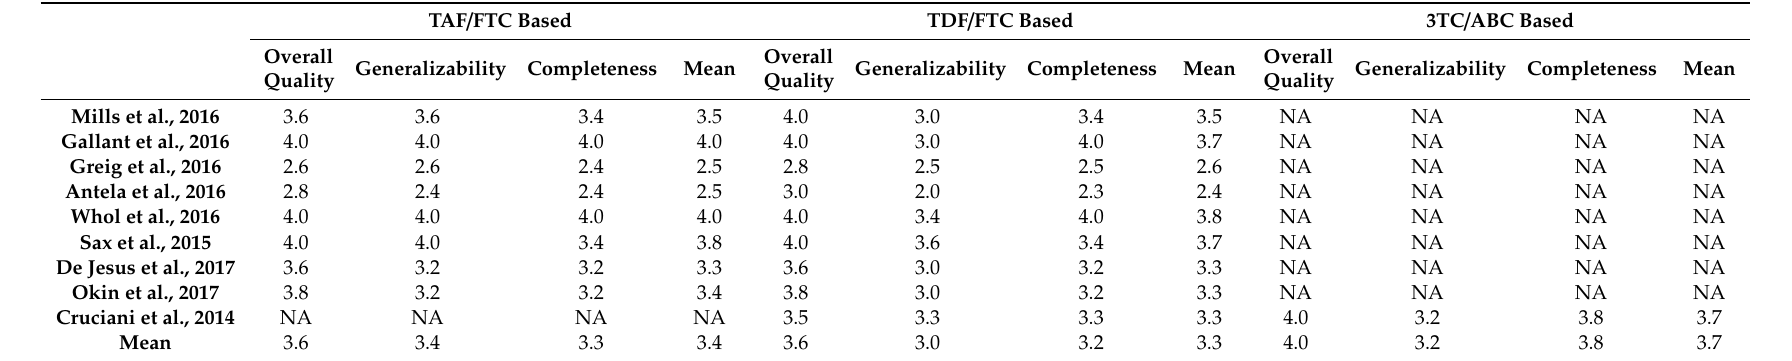
Table 2. Validation of the selected literature. Source: data gathered by authors based on expert opinion.